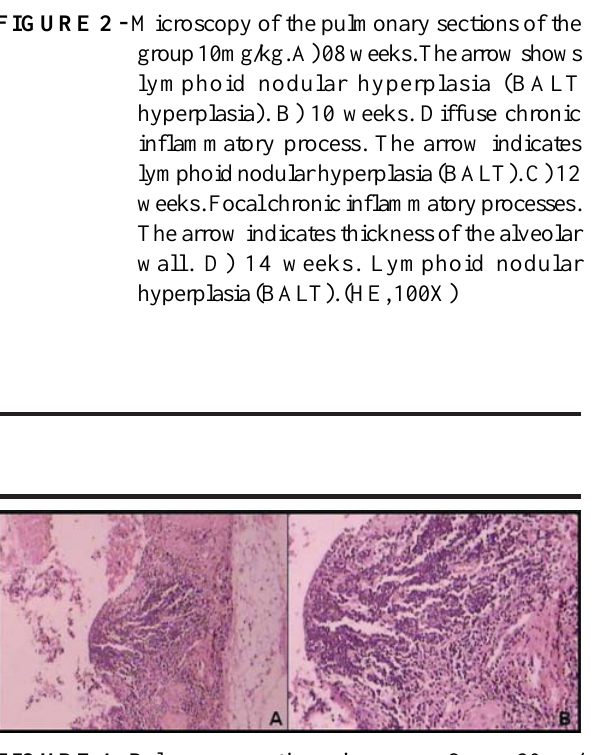
FIGURE 4 - Pulmonary section microscopy. Group 20mg/ kg, 12 weeks. Pleomorphism compatible with adenocarcinoma in situ . (HE,: 50X; B: